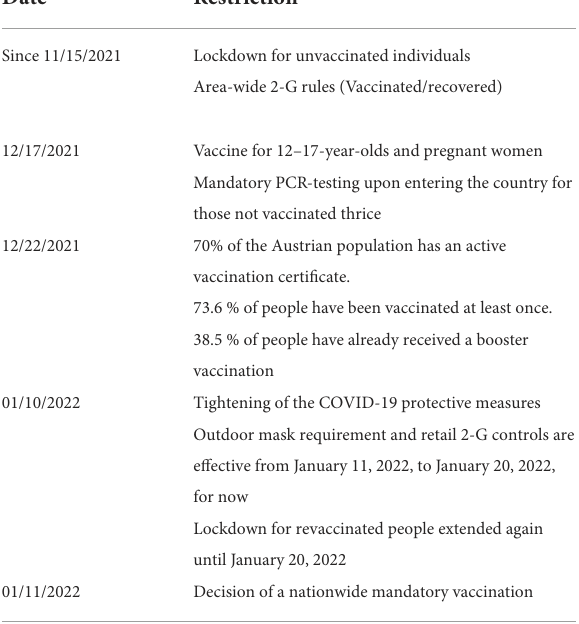
TABLE 2 COVID-19 restrictions in Austria between November 2021 and January 2022 (14,